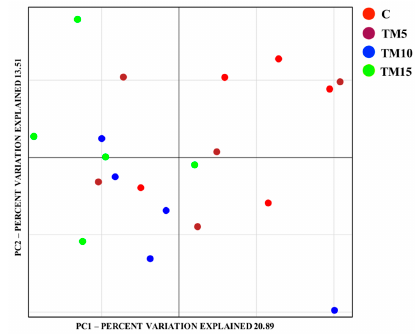
Figure 1. Bacterial community composition (weighted UniFrac beta diversity, principal component analysis plots) in cecal samples of male broiler chickens fed with control (C), 5% (TM5), 10% (TM10) and 15% (TM15) inclusion level of Tenebrio molitor meal diets.